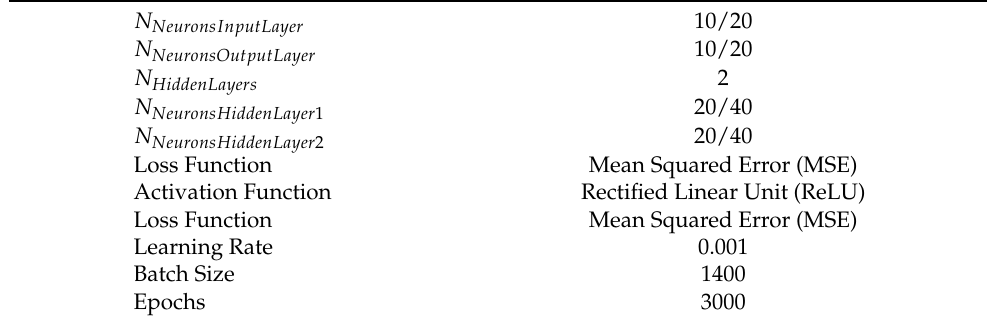
Table 4. Parameters for FNN (w/o slp and w/ slp) for 10 s prediction. N NeuronsInputLayer